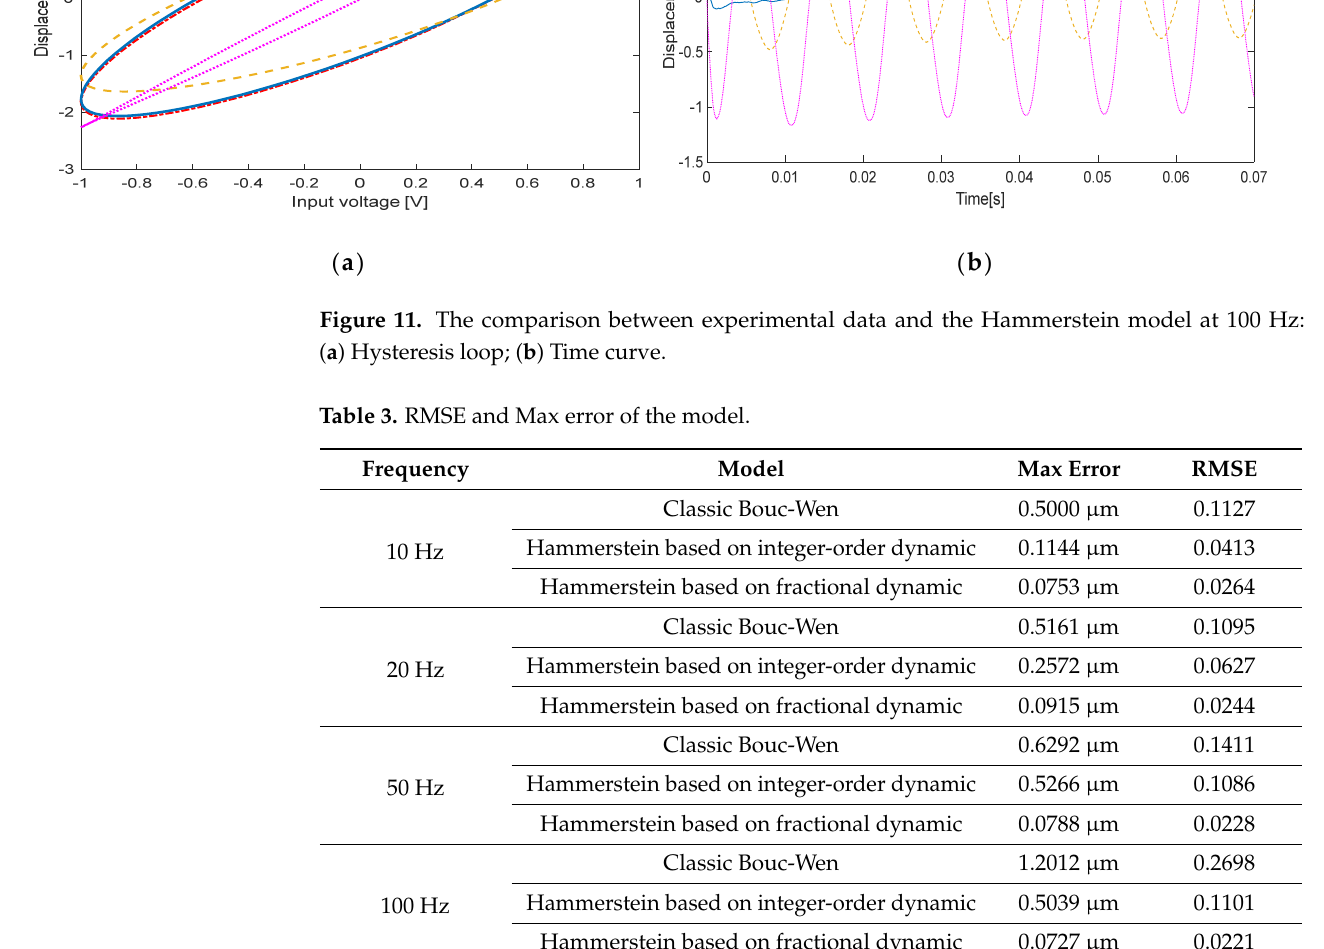
( b ) Figure 10. The comparison between experimental data and the Hammerstein model at 50 Hz: ( a ) Hysteresis loop; ( b ) Time curve.